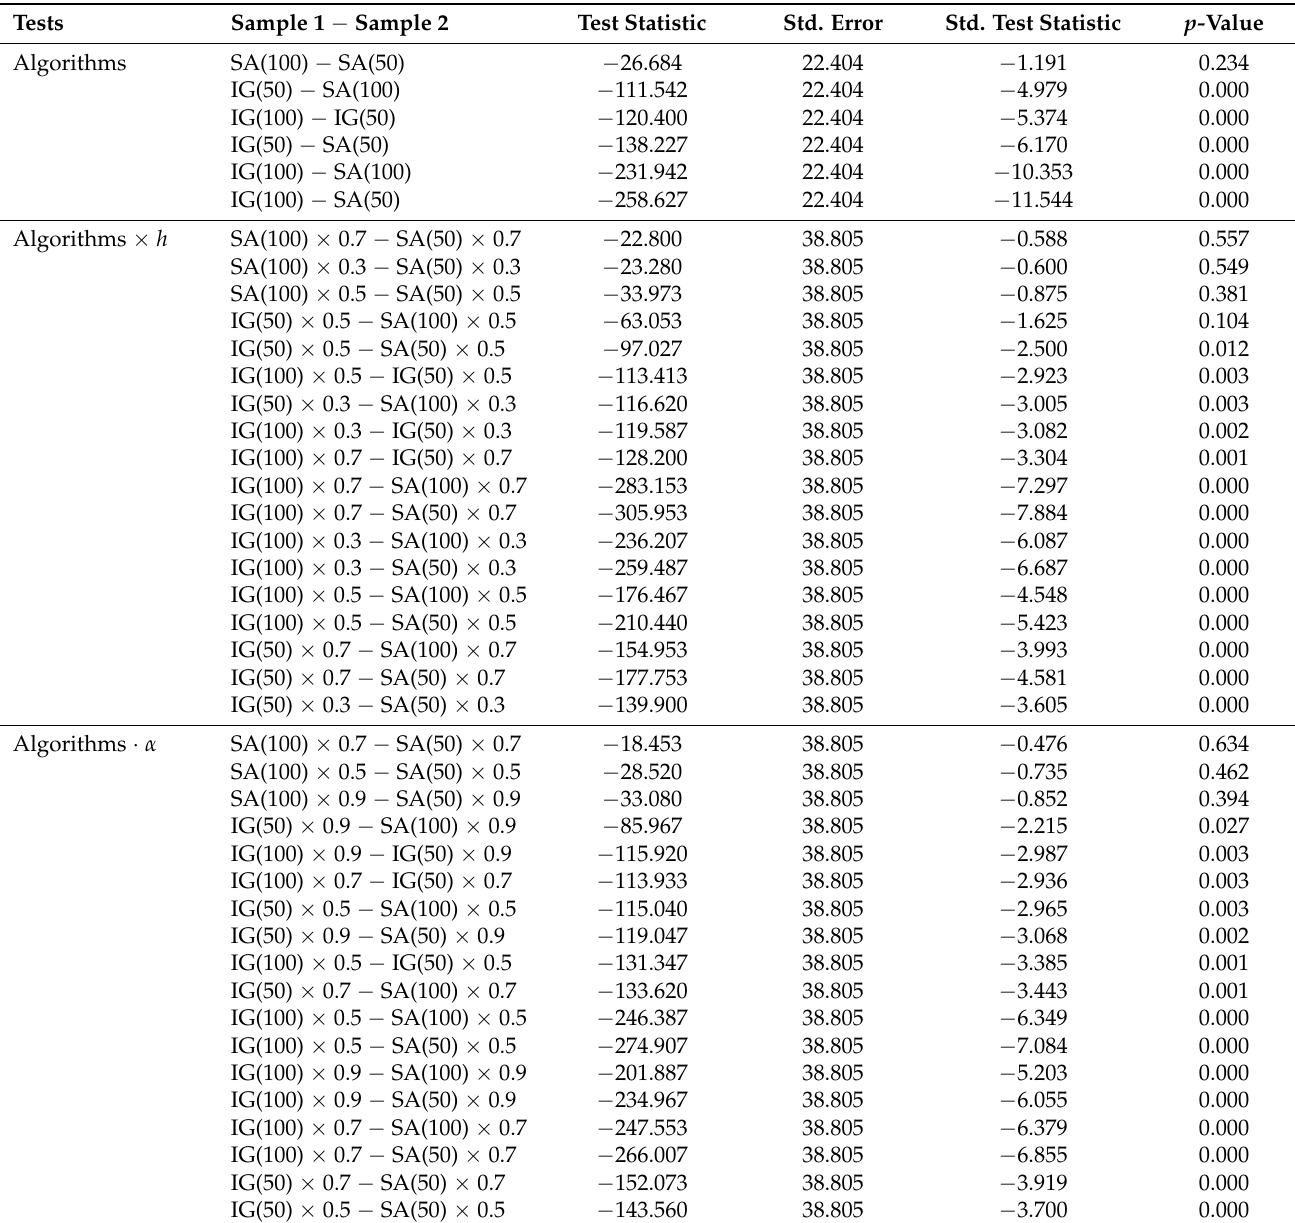
Table 5. Pairwise comparisons from Kruskal—Wallis tests for the small